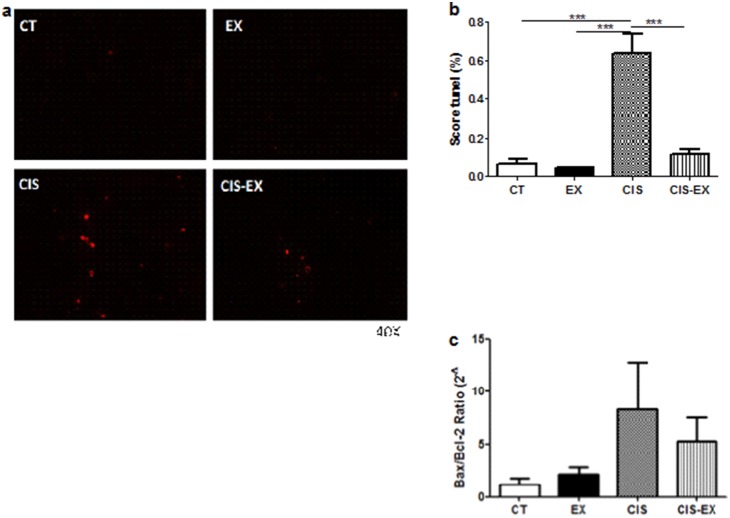
Aerobic exercise reduces cell death in the kidney.Representative TUNEL staining (A) and quantification (B) showed a significantly reduced percentage of TUNEL-positive cells (dead cells) in the CIS-EX group. The expression of Bcl2 and Bax genes was evaluated by qPCR and is represented by the ratio of the pro- to the anti-apoptotic molecule (Bax/Bcl2) (C) the CIS group was more likely to exhibit a pro-apoptotic profile, confirming the protective role of exercise. ***P<0.001.